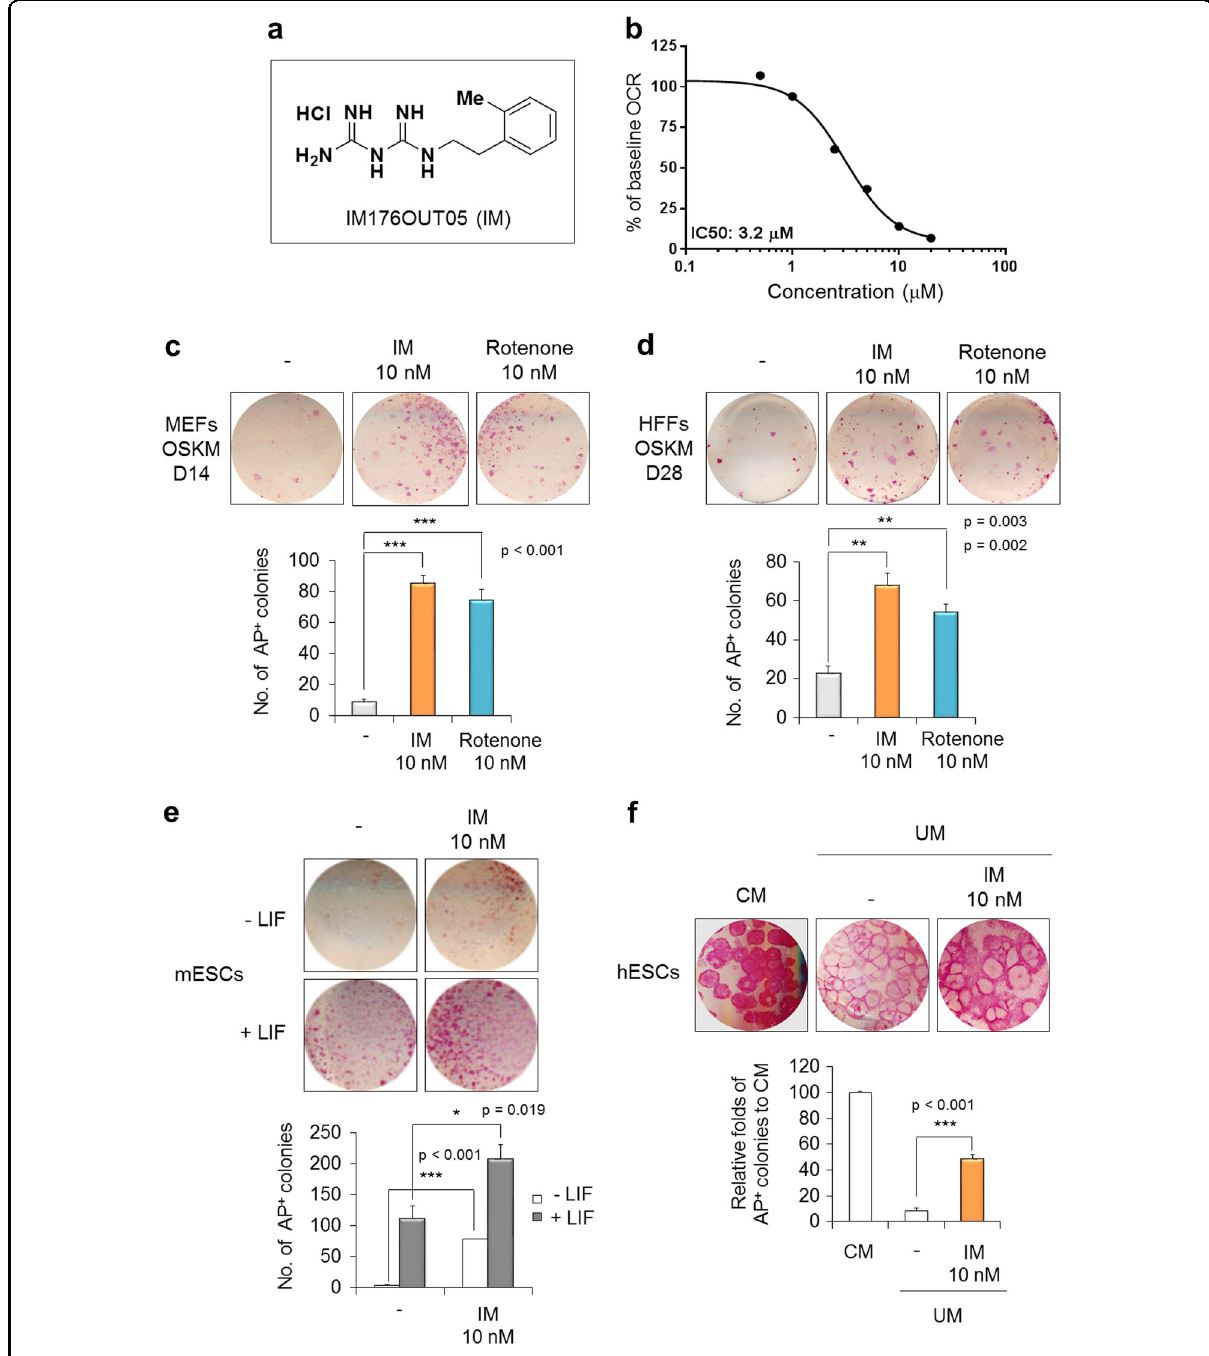
Fig. 1 IM176OUT05 (IM) improves the acquisition and maintenance of stem cell pluripotency. a Chemical structure of IM. b Dose-response curve of the inhibition of the ETC by IM in the A549 lung carcinoma cell line. Cells were treated with serially diluted IM for 24 h, and the basal OCR was measured using a Sea Horse XF Analyzer. c MEFs and d HFFs were reprogrammed into iPSCs with OSKM reprogramming factors in the presence of 10 nM IM or rotenone. Representative images of AP + colonies are shown (top). The total number of AP + colonies was counted on day 14 (D14, MEFs) or day 28 (D28, HFFs) of reprogramming (bottom). e mESCs cultured under the non-self-renewing conditions ( − LIF) or self-renewing conditions ( + LIF) were treated with 10 nM IM for 4 days. Representative images of AP + colonies (top) and the total number of AP + colonies are shown (bottom). f hESCs were maintained under the self-renewing condition (CM). hESCs cultured under non-self-renewing conditions (UM) were treated with 10 nM IM for 6 days. Representative images of AP + colonies (top) are shown, and the relative AP expression was quanti fi ed by scanning densitometry (bottom). * p < 0.05; ** p < 0.01; *** p < 0.001 (Student ’ s t